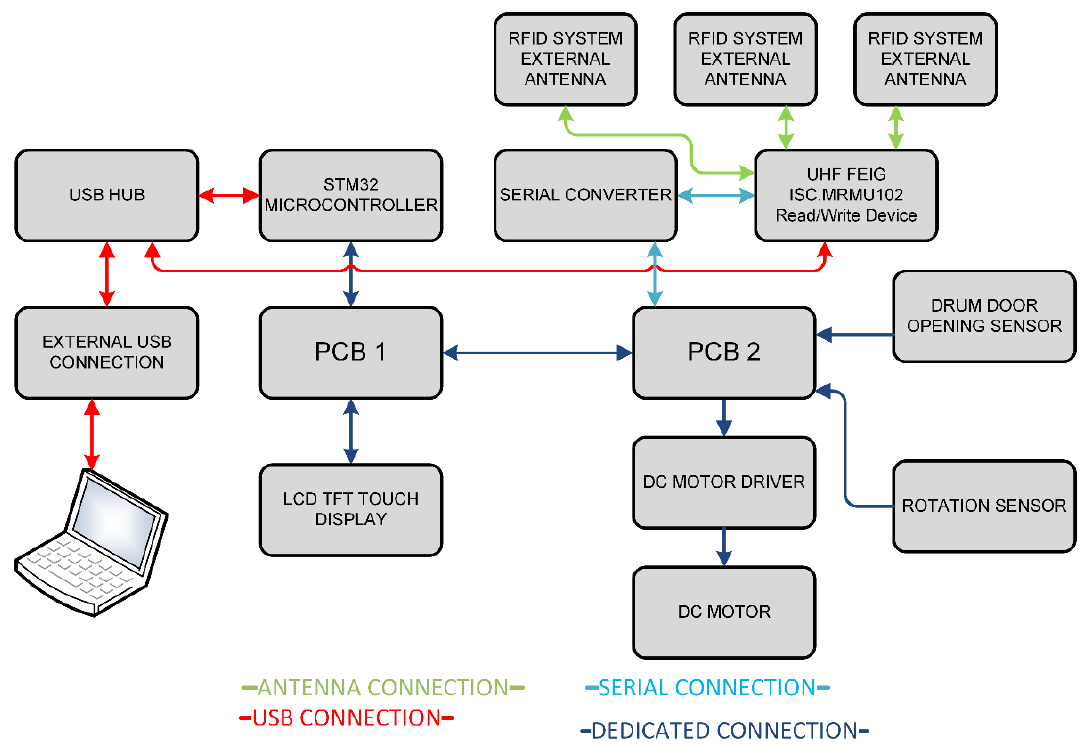
Figure 5. Detailed block diagram of the electrical part developed with the IoTT-enabled washing machine demonstrator and connected sensors.